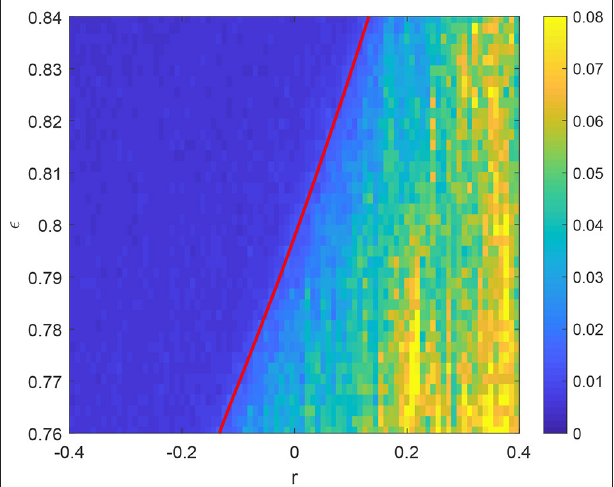
Z FIGURE 15 | Difference between the maximum of over the last 50 time | | units out of 100 and the minimum, having already discarded the first 50 as transient. p ( ω 0 ) is uniform on [0,2]. The red curve shows the Hopf bifurcation of the steady state of (51) which is stable to the left of this curve. Other k parameters: β 0, 1 0.01, 100, N 2,000. We use m 20 bins to = = h i = = = calculate the blue